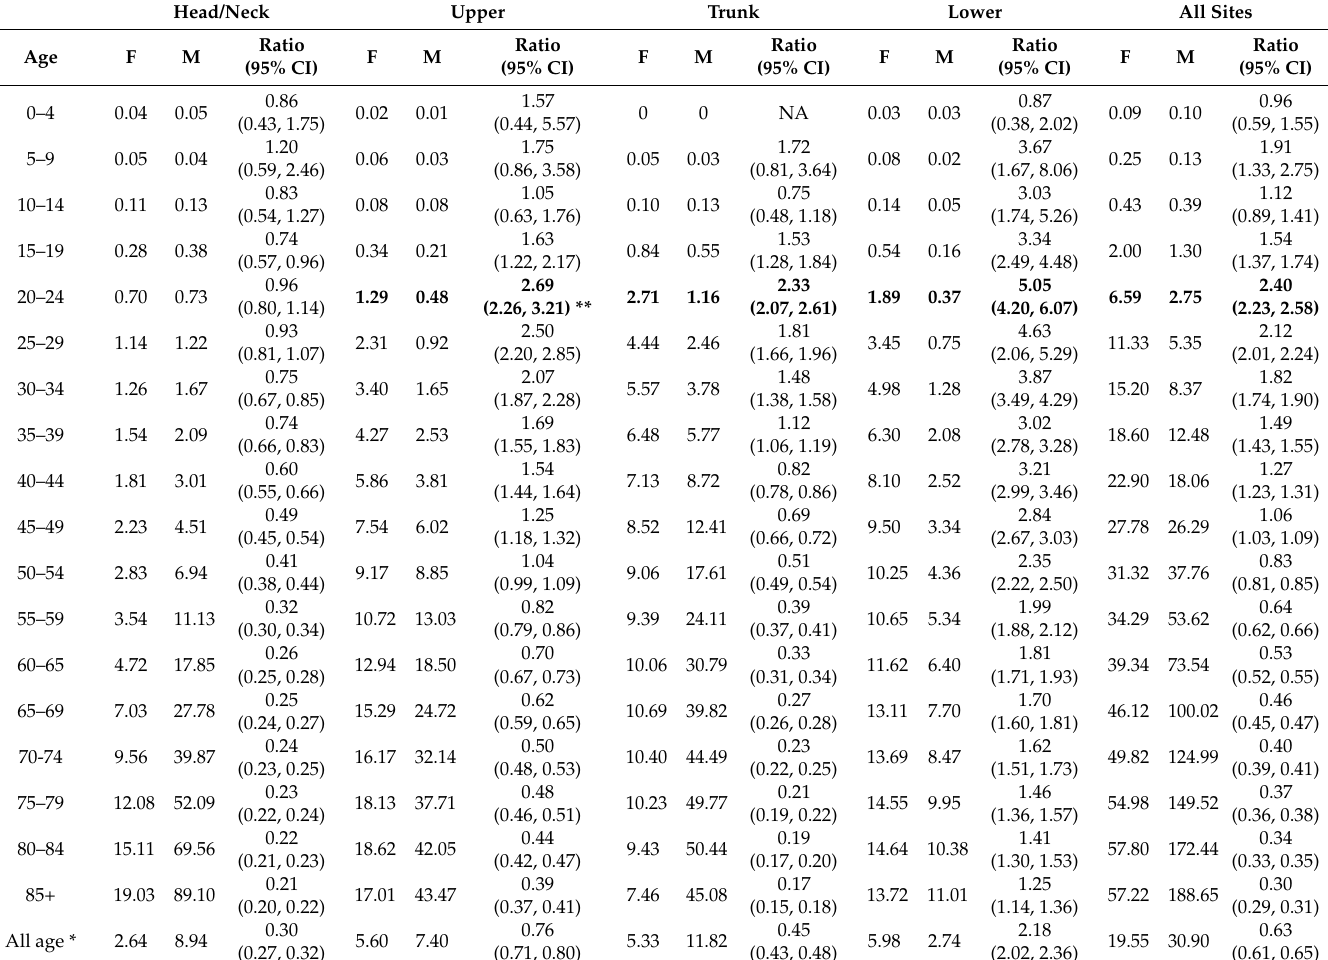
Table 2. Age- and site-specific incidence rates (per 100,000 person-years) and rate ratios (F/M) in the white population. Head/Neck Upper Trunk Lower All